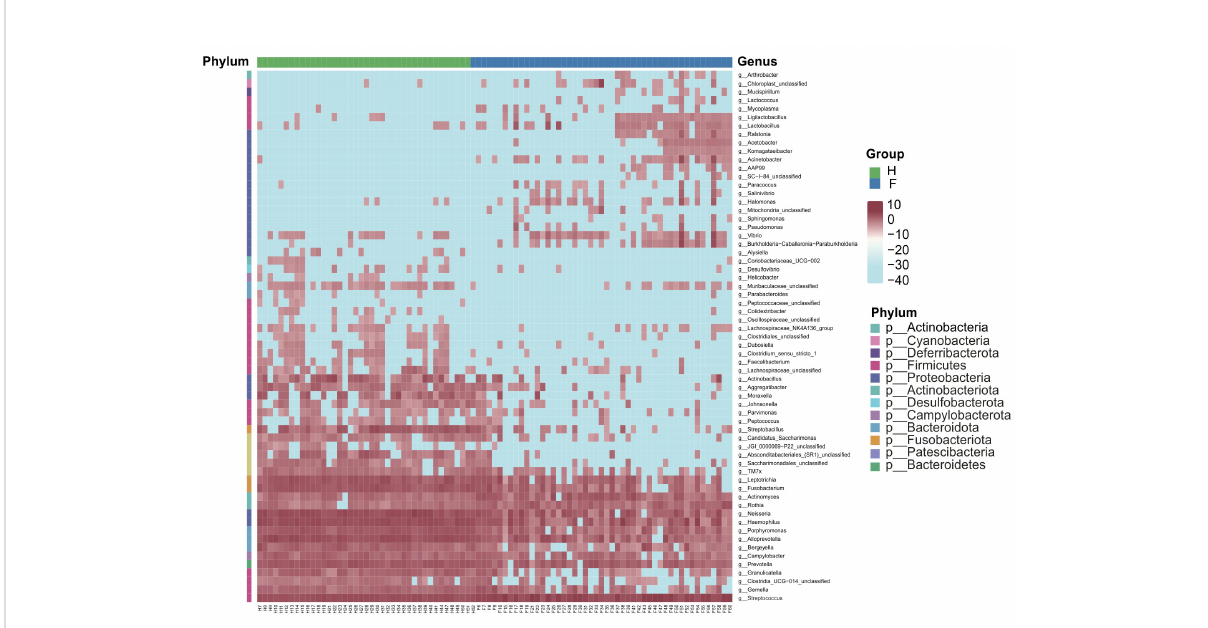
FIGURE 2 The two groups have similarities and differences in composition at the phyla and genera levels. The data after Z-transformation showed the abundance of genera, which was lower in the blue section and higher in the red section. F, IAV pneumonia group (blue); H, healthy group (green). IAV, in fl uenza A